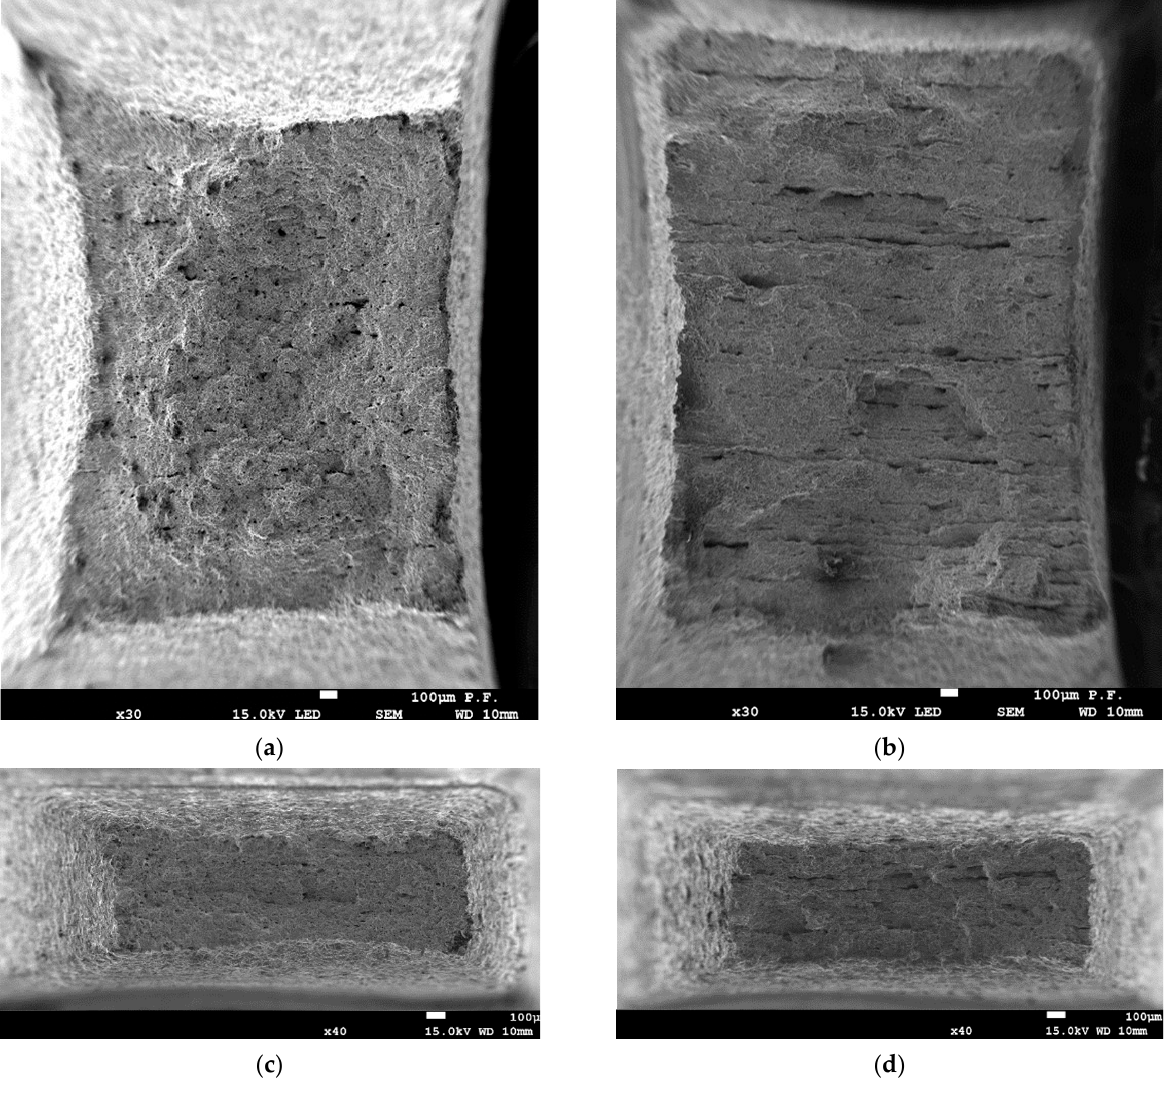
Figure 9. Examples of the macro fracture surfaces of specimens made from steel A with a thickness of 5.0 mm ( a , b ) and 1.2 mm ( c , d ), cut out along ( a , c ) and across ( b , d ) the rolling direction.